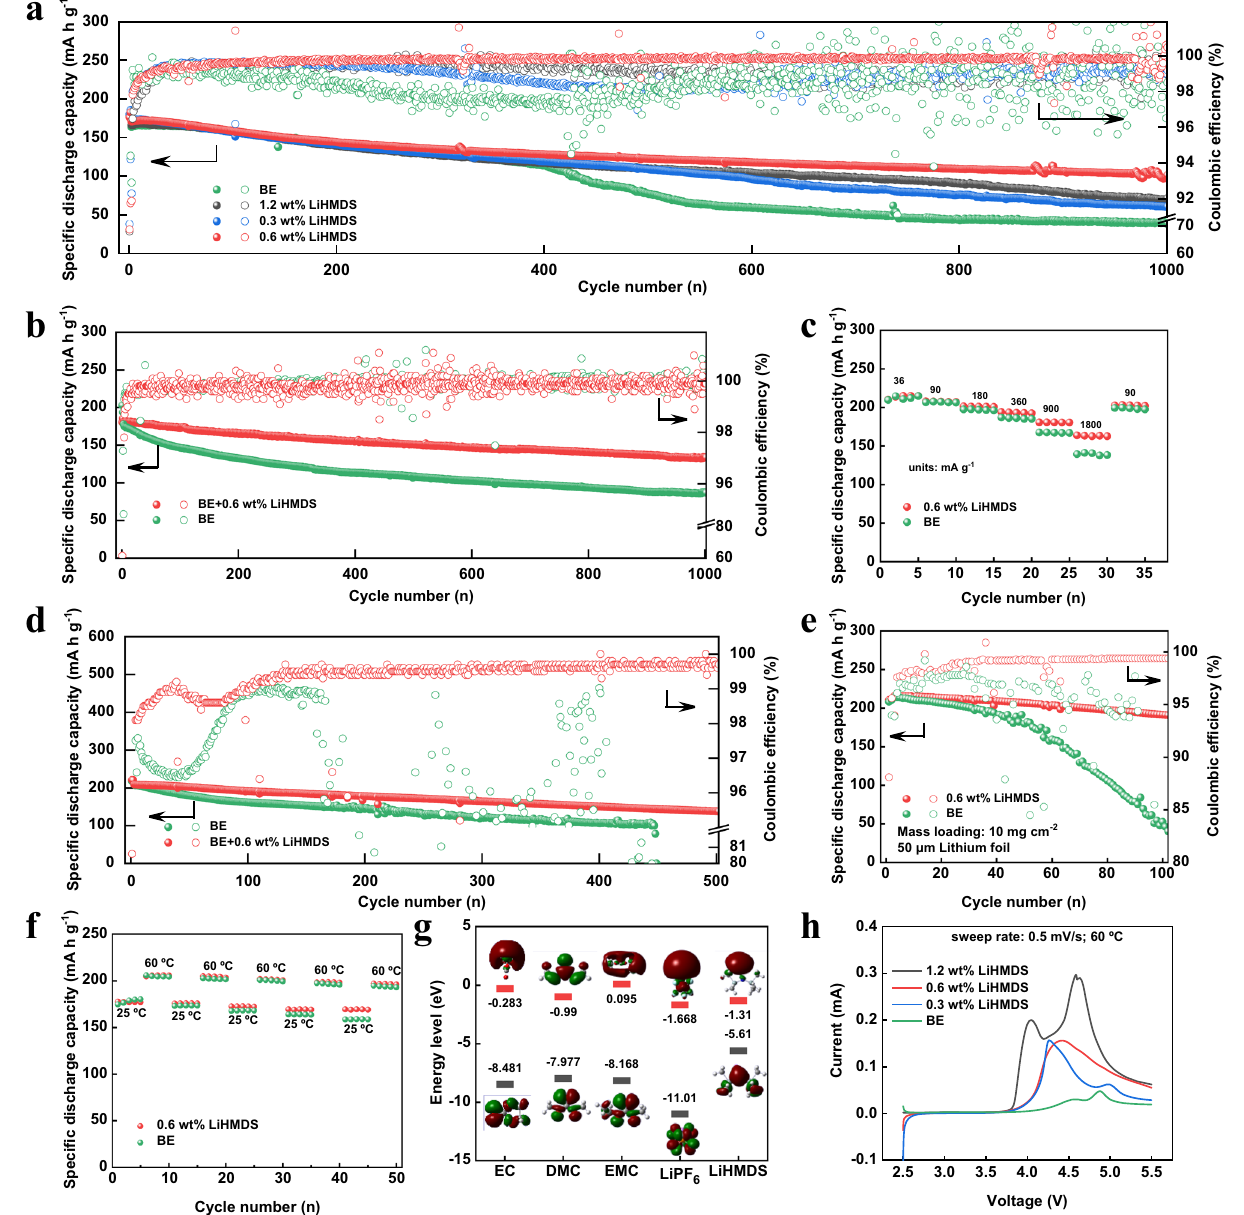
Fig. 1 | Electrochemical performance of Li||NCM811 cells with and without LiHMDS. a Cycling performance of Li||NCM811 cells with different amount of LiHMDSat 25°C between 2.8and 4.3V, speci fi c current is 180mAg − 1 . b Cycling performance at 25°C between 3 and 4.5V, speci fi c current is 90mAg − 1 . c Rating performance at 25°C. d Cycling performance at 60°C between 3 and 4.5V, speci fi c current is 180mAg − 1 . e Cycling performance of thin Li